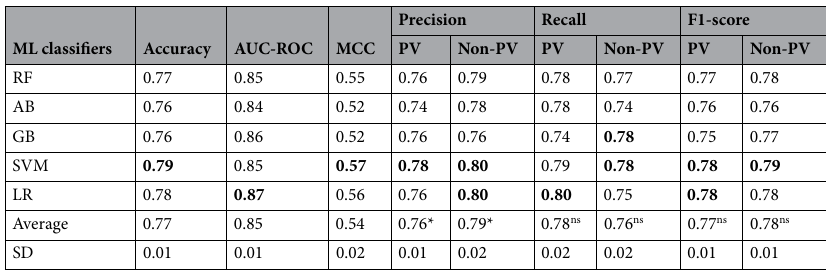
Table 4. The best performance of different machine learning algorithms. Bold letter indicates best score in each measure. ML machine learning, AUC-ROC area under the receiver operating characteristic curve, MCC Matthews correlation coefficient, PV peripheral vestibular disease, non-PV non-peripheral vestibular disease, RF Random Forest, AB AdaBoost, GB Gradient Boosting, SVM Support Vector Machine, LR Logistic Regression, SD standard deviation. *P < 0.05 between PV and non-PV, ns no significant difference between PV and